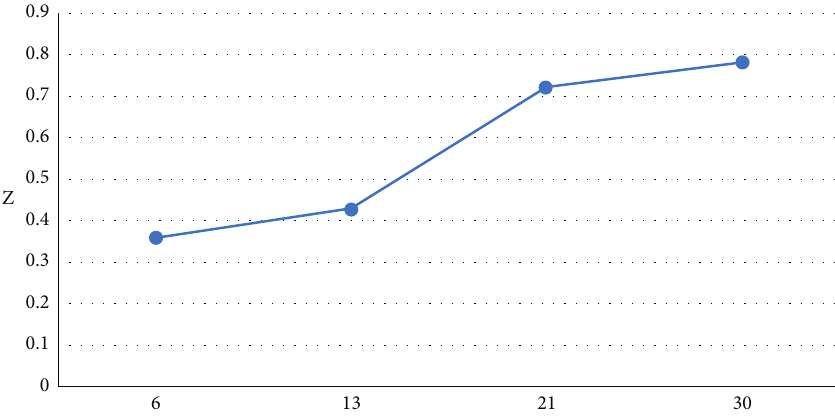
Figure 4: The change curve of visual comfort with chromaticity (the third